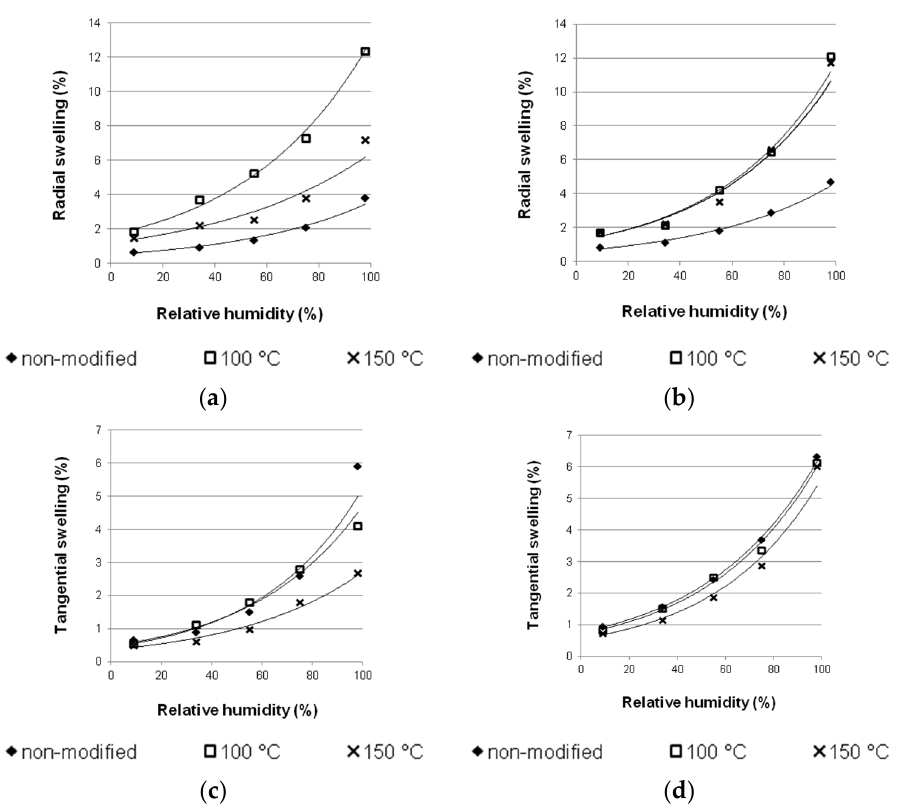
Figure 5. Dimensional changes of thermo-mechanically modified wood depending on relative humidity of air: ( a ) iroko—radial swelling; ( b ) tauari—radial swelling; ( c ) iroko—tangential swelling; ( d ) tauari—tangential swelling.